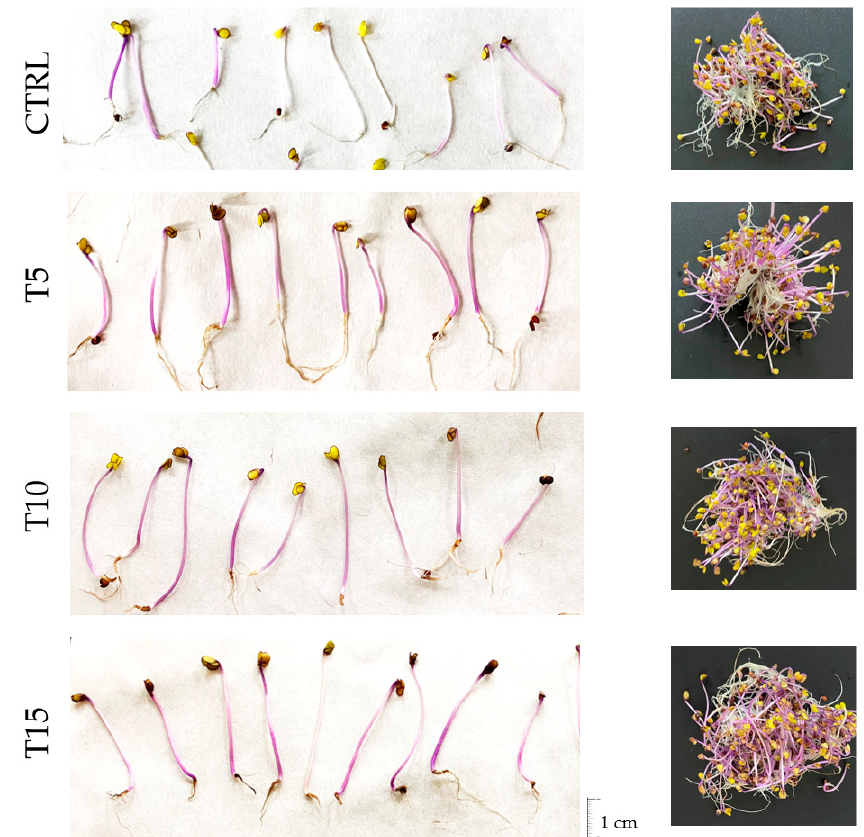
Figure 2. Representative pictures of control (0, CTRL) or UV-B-treated (5, 10, and 15 kJ m − 2 ) red cabbage sprouts after 10 growing days at 20 °C and 90% RH.